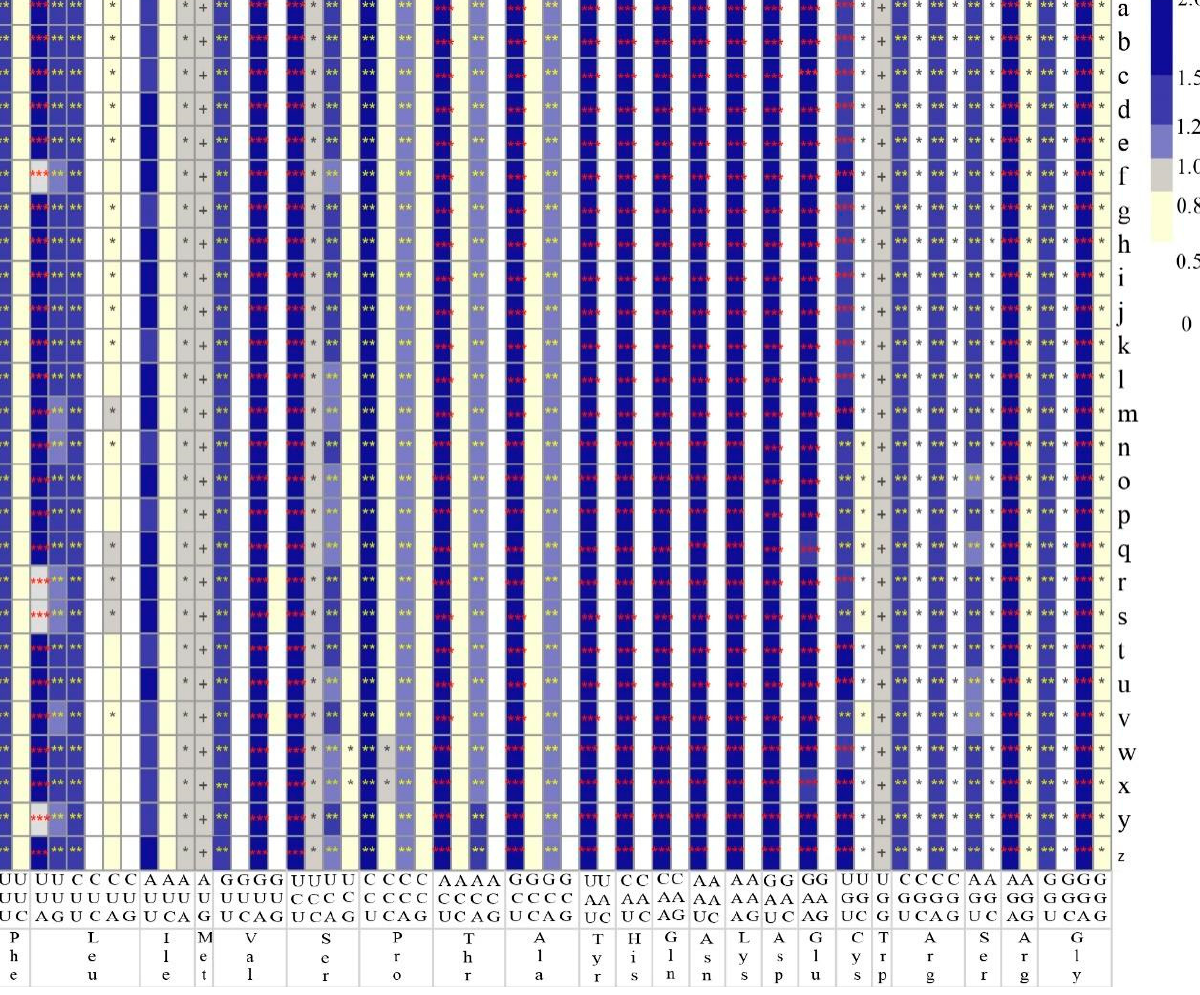
Figure 2. Analysis of the relative synonymous codon usage (RSCU) of chloroplast genomes of 26 Juglandaceae plant species. * indicates RSCU = 0.8–1, ** indicates RSCU = 1–1.5, *** indicates RSCU > 0.5, + indicates RSCU = 1. Lowercase letters from a to z indicate “ J. regia (a), J. regia 192 (b), J. regia 193 (c), J. regia 194 (d), J. regia 196 (e), J. regia 197 (f), J. regia 198 (g), J. regia 199 (h), J. regia 200 (i), J.